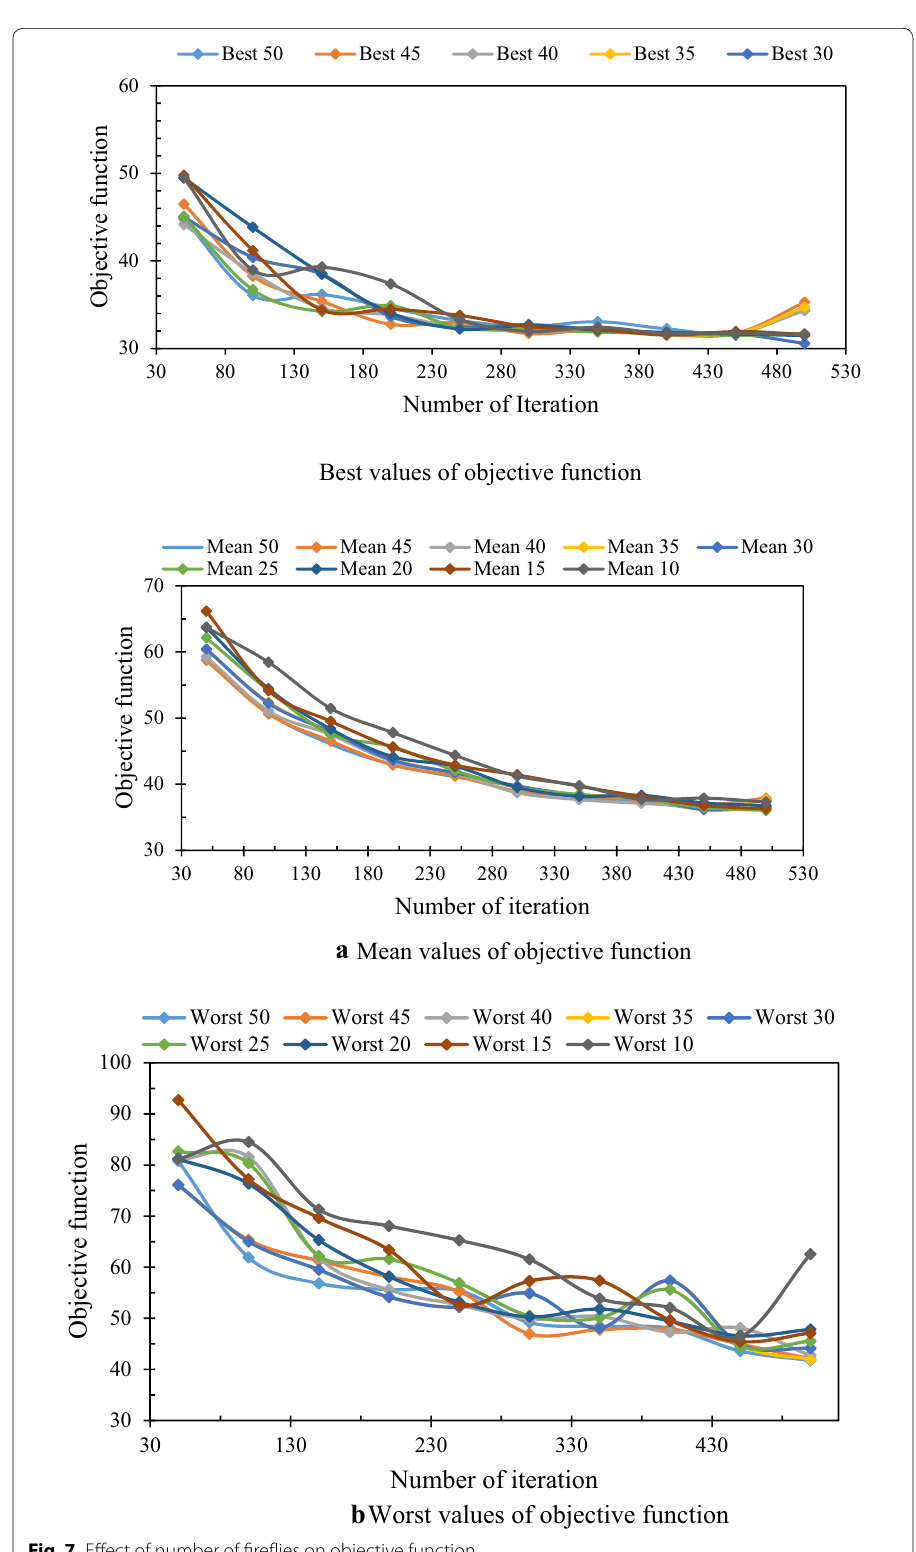
Fig. 7 Effect of number of fireflies on objective